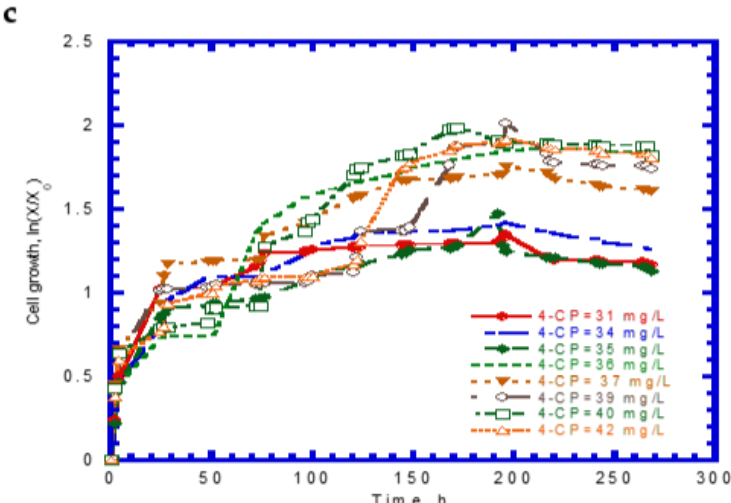
Figure 6. Experimental results for the biodegradation of binary substrates of sodium salicylate and 4-CP in the presence of sodium salicylate with an initial concentration of 124 mg/L: ( a ) sodium sa- licylate, ( b ) 4-CP, and ( c ) P. putida cells.